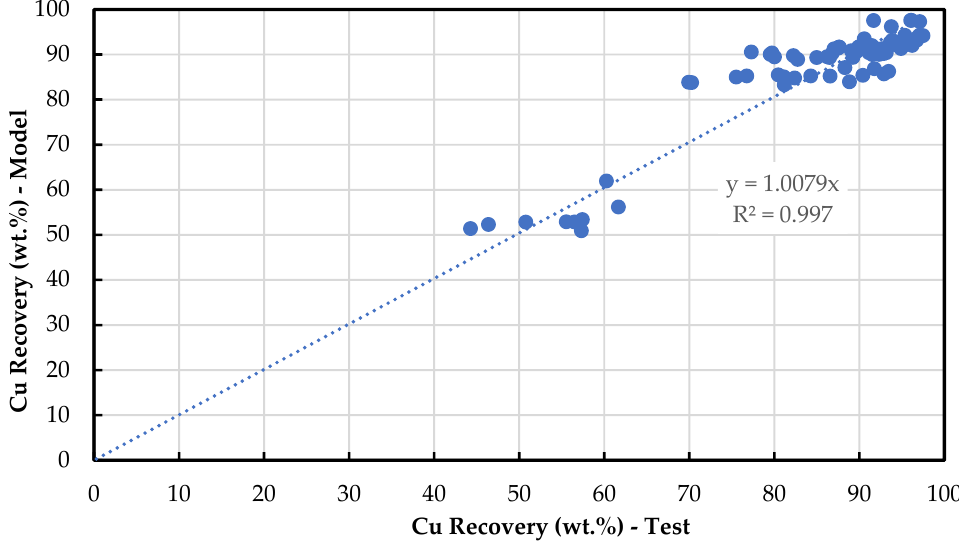
Figure 20. Copper recovery from the rougher flotation tests versus copper recovery from the model (Table 9).